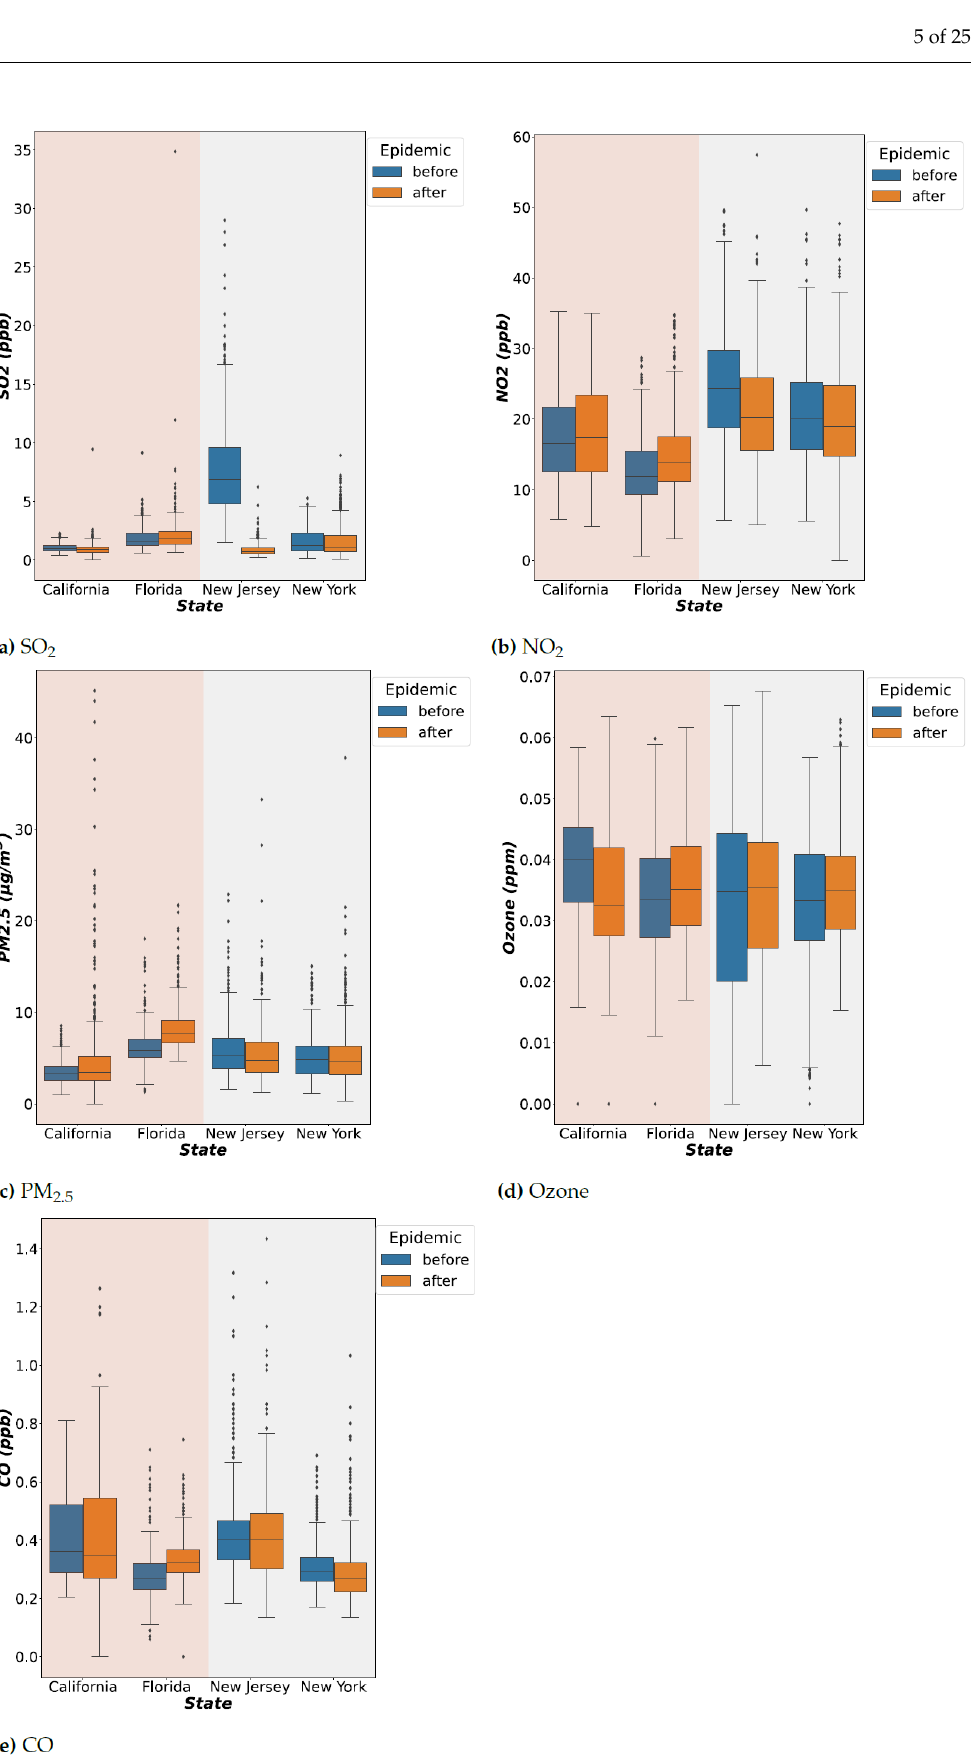
Figure 2. Air pollutant data (SO 2 , NO 2 , PM 2.5 , Ozone, and CO) of each state before and after the COVID-19